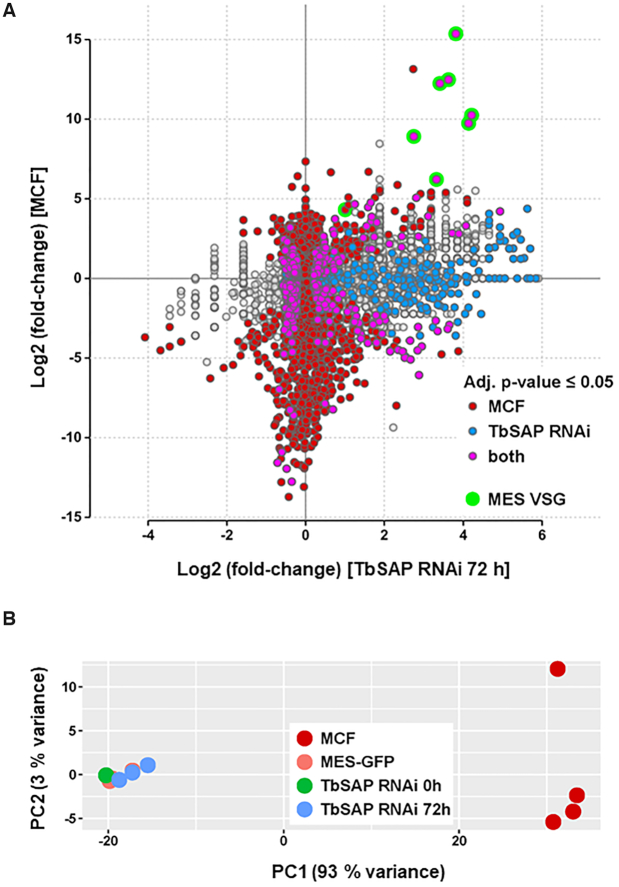
Comparison of the TbSAP RNAi transcriptome with a previously published metacyclic transcriptome reveals that although the induction of TbSAP RNAi results in the upregulation of metacyclic VSGs, this does not lead to ‘metacyclic-like’ cells. (A) Transcripts are indicated with dots, with changes in expression level after the induction of TbSAP RNAi for 72 h relative to uninduced parental cells (MES-GFP), shown on the X-axis. This is plotted against differential expression of transcripts in the metacyclic form (MCF) transcriptome described in (42) compared with parental MES-GFP cells on the Y-axis. Differentially expressed genes in either comparison (adjusted P-value ≤ 0.05) are highlighted. Transcripts which are only differentially expressed in the metacyclic form transcriptome are indicated in maroon. Transcripts which are only significantly changed after the induction of TbSAP RNAi for 72 h are indicated in blue. Transcripts which are significantly changed in both transcriptomes are indicated in pink, with MES VSGs indicated with green circles. Transcripts which have not significantly changed with respect to the transcriptome of the parental cells are indicated with grey circles. (B) Principal component analysis of sample to sample distances of the metacyclic form (MCF), parental (MES-GFP) or TbSAP RNAi (MES-GFP TbSAP) transcriptomes. The first two dimensions covering 96% of the variance are shown. Samples are coloured according to group.